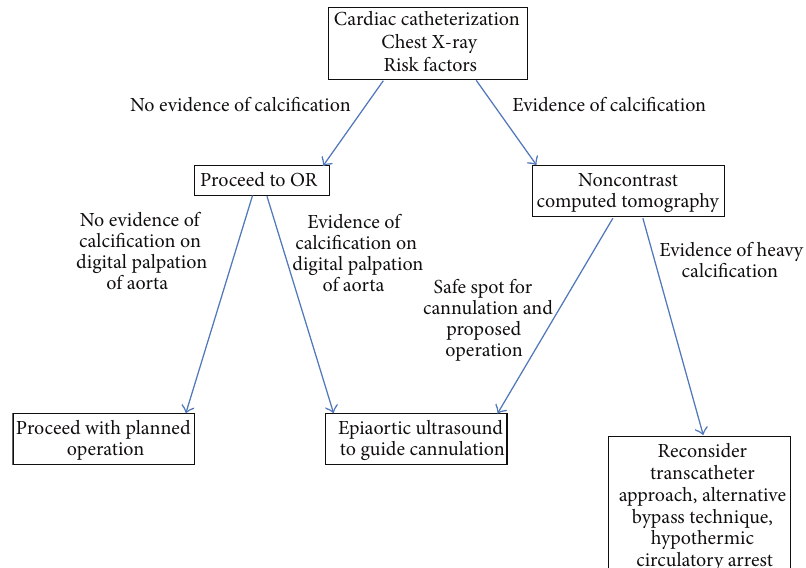
Figure 2: Proposed algorithm to avoid the “unexpected” intraoperative discovery of a heavily calcified